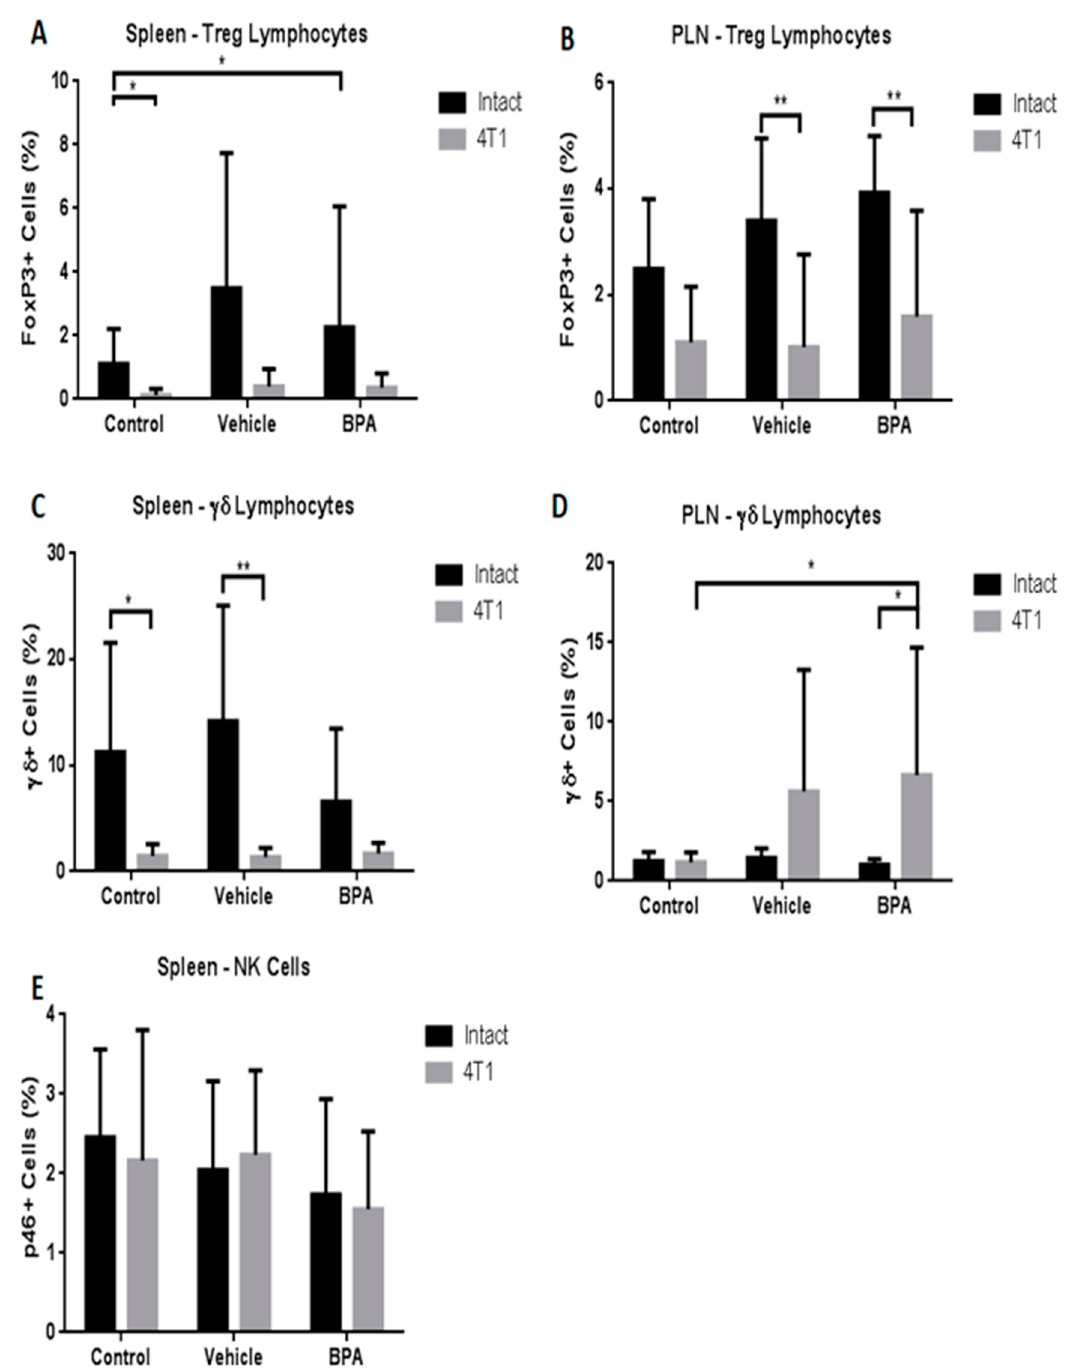
Figure 5. Percentages of regulatory T cells, T γδ cells ( γδ + cells) and natural killer (NK) subpopulations in the spleen and PLN in the offspring of BPA treated mice. Differences in cellular percentages by treatment in spleen and peripheral lymph nodes (PLN) in regulatory T cells ( A , B ), T γδ lymphocytes ( C , D ), and NK ( E ) cells, control ( n = 7), vehicle ( n = 6), vehicle/4T1 ( n = 7), BPA ( n = 7), and BPA/4T1 ( n = 5). The data shows the mean and standard deviation of the population percentage (* p < 0.05, ** p < 0.01 and *** p < 0.001).